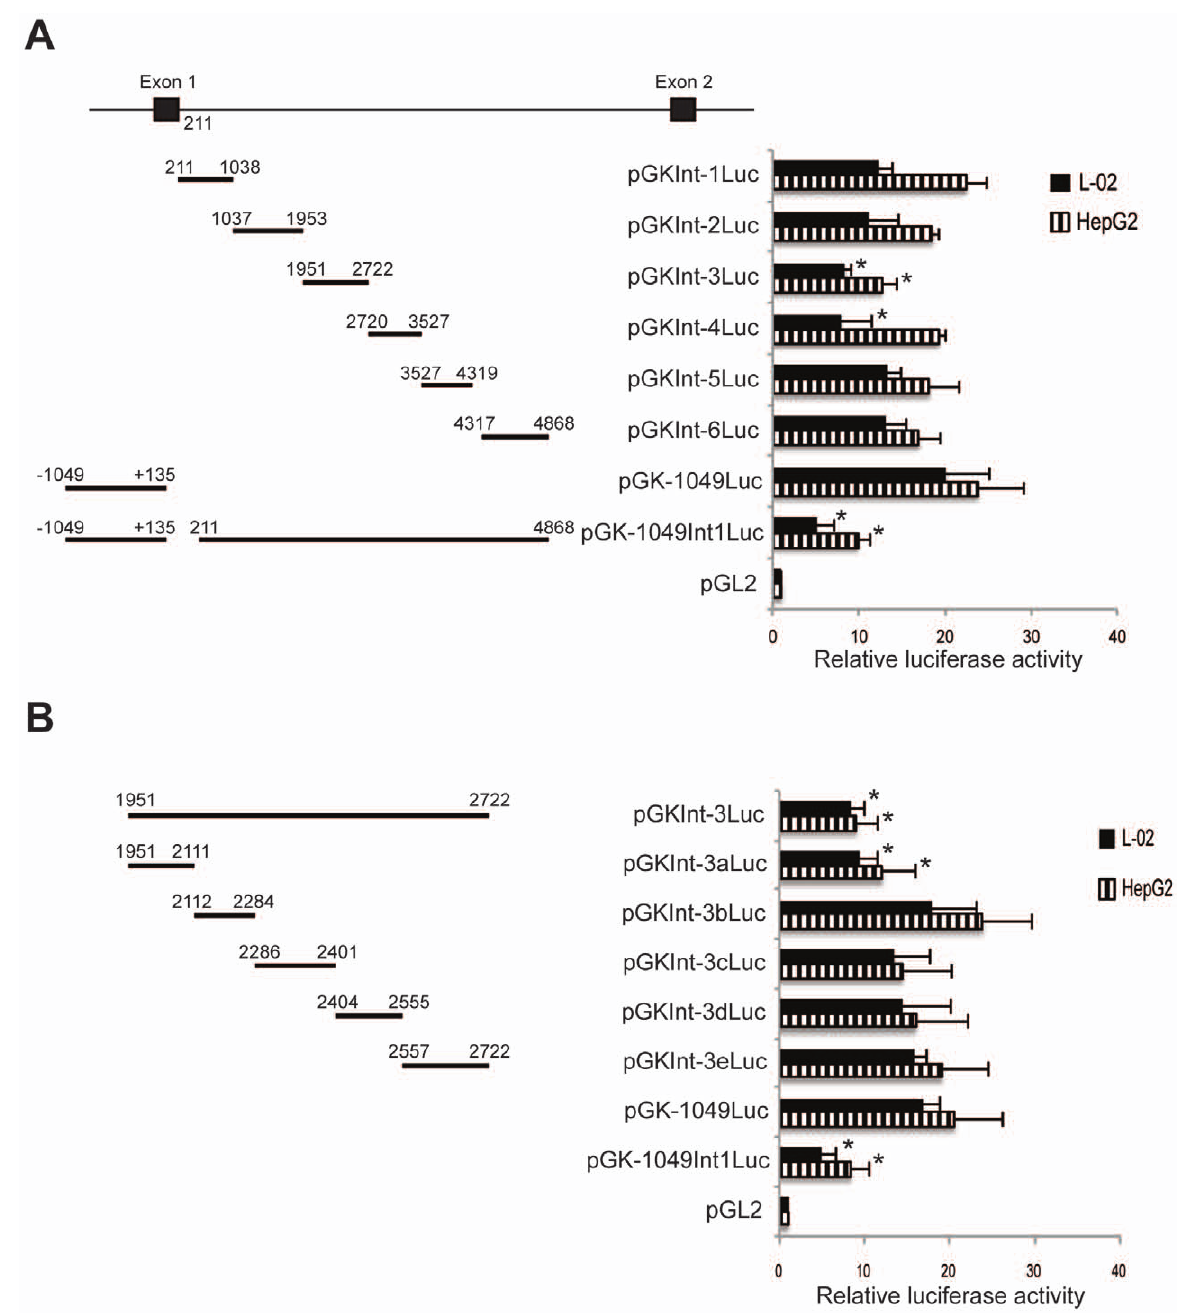
Figure 4. Analysis of the transcriptional activity of fragments of intron 1 of the human GCK gene. A. Activity of large fragments spanning most of intron 1. B Activates of subfragments of intronic fragment Int-3 (I-3). Schematics on the left indicate the relative positions of fragments of intron 1 inserted downstream of a luciferase reporter gene in the pGK-1049Luc reporter plasmid. See Fig. S1 for the locations of genomic fragments within the gene. Reporter gene activities of the constructs in human L-02 and HepG2 cells are shown on the right. Data are the Mean 6 SD of three independent experiments. Asterisk (*) indicates constructs that have significantly different activity than the 2 1049 construct (P , 0.05).